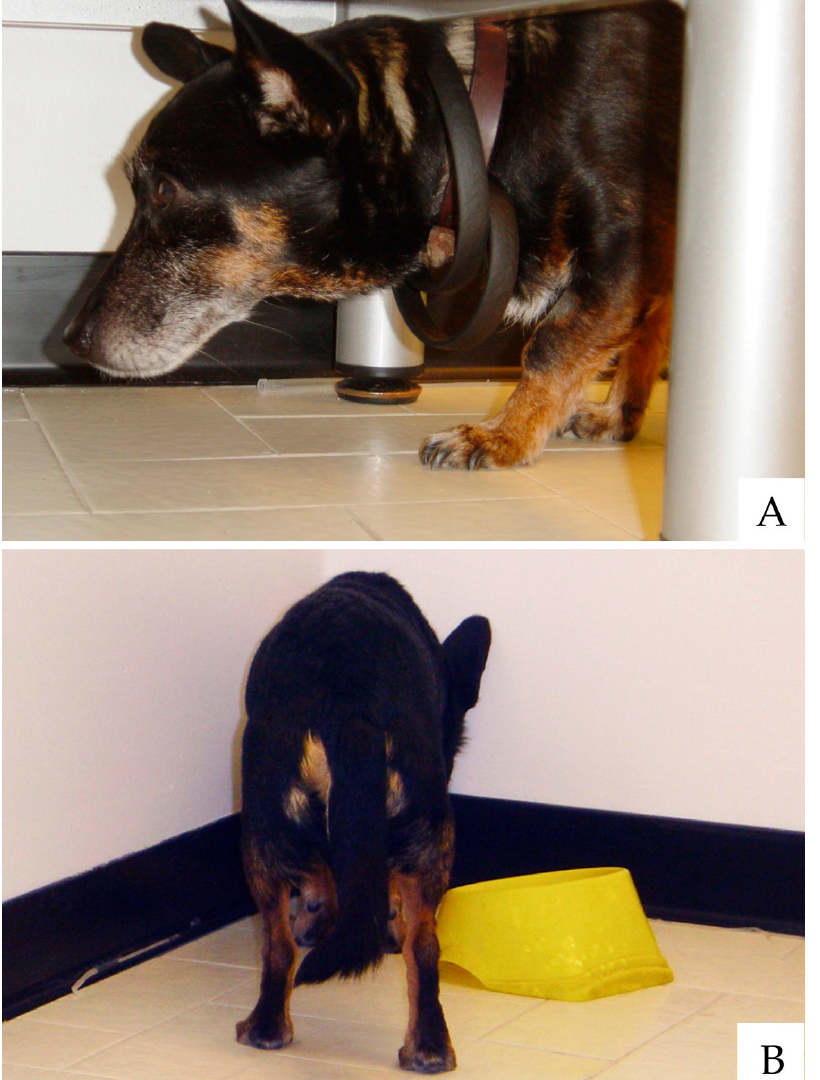
Figure 1. Old dogs often appear confused or disoriented. Getting “stuck” under furniture without apparently knowing how to get out from there ( A ) or standing headfirst in corners or tight spaces ( B ) are common signs of canine CDS.(photo by Lorenzo